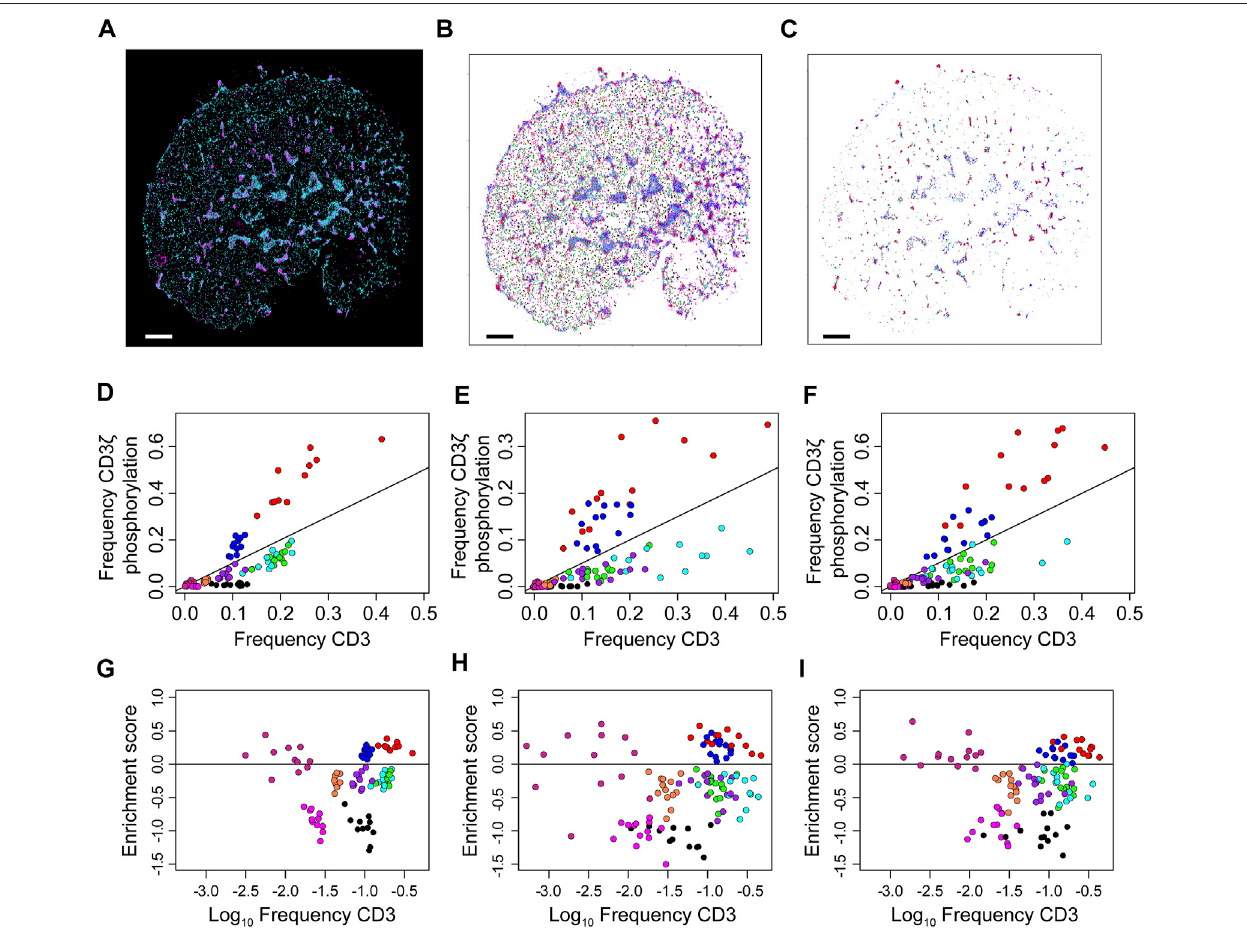
FIGURE 7 | Over- and under-representation of CD3 ζ phosphorylation for each of nine co-existing spatial organisations in cells expressing TCR, fi rst generation CARorsecondgenerationCAR. (A) Two-colourSMLMimagesofCD3 ζ (cyan)andphosphorylatedCD3 ζ (pCD3 ζ ,magenta)oftheTCR-CD3complexinaJurkatILAcell activated on a pMHC-decorated bilayer. (B) SMLM images of CD3 ζ with localisation colour-coded according to the nine spatial groups. (C) SMLM images of CD3 ζ that are within 10 nm of pCD3 ζ localisations. The frequency of these CD3 ζ localisations are plotted in (D – F) . Colour key as in (B) . In (A – C) , scales bar (cid:1) 2.5 μ m (D – F) . FrequencyofCD3 ζ phosphorylation asafunctionofthepercentage oftotalCD3 ζ localisations amongtheninespatialorganisationsforTCR (D) , fi rstgenerationCAR (E) and second generation CAR (F) . Each symbol represents one spatial group from one SMLM image. The black line indicates no preference in phosphorylation; groups above the line are preferably phosphorylated, groups below the line are under-represented in CD3 ζ phosphorylation. Note the similarity between the three receptor types. (G – I) Phosphorylation enrichment score as a function of CD3 ζ occupancy in the nine spatial organisations for TCR (G) , fi rst generation CAR (H) and second generation CAR (I) . Each symbol represents one spatial group from one SMLM image. Symbols above the black horizontal line represent spatial groups that are over- represented in CD3 ζ phosphorylation; symbols below the black line represent spatial groups that are under-represented in CD3 ζ phosphorylation. The phosphorylation patterns are not signi fi cantly different over the three experimental groups